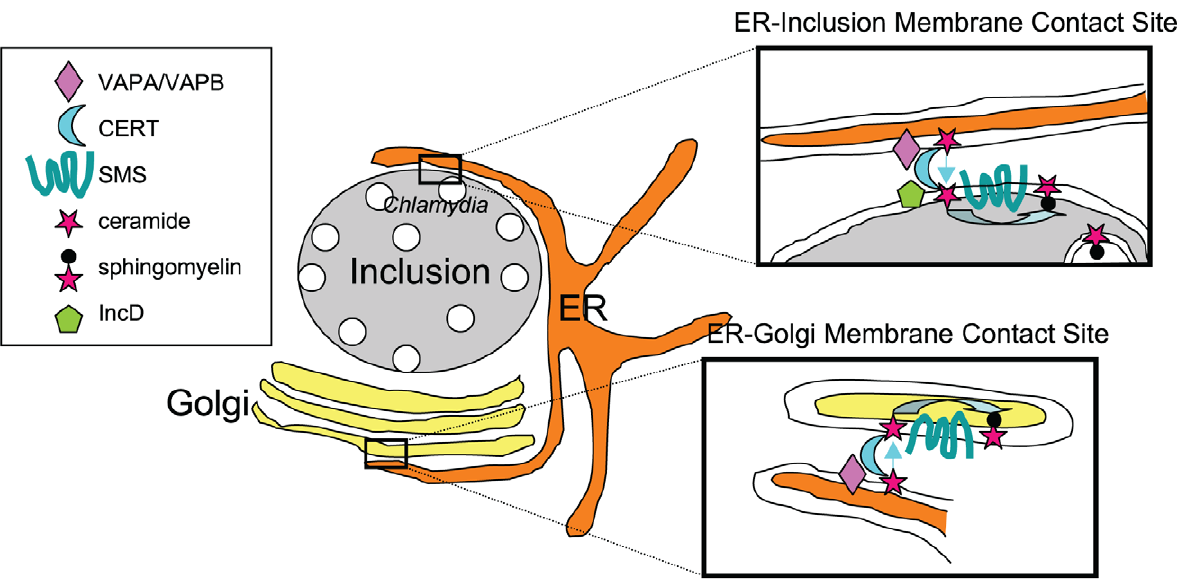
Figure 1. Direct transport of ceramide from the ER to C.trachomatis inclusion. At ER-Golgi membrane contact sites the ceramide transfer protein CERT associates to the ER-resident proteins VAPA/VAPB and, via its PH domain, to PI4P at the trans -Golgi. Upon transfer by CERT, ceramide is converted to SM by a SM synthase (SMS). In Chlamydia -infected cells, ER-inclusion membrane contact sites involving VAPA/VAPB and CERT are observed. CERT interacts with the inclusion-anchored bacterial protein IncD through its PH domain but independently of PI4P. Upon transfer to the inclusion membrane, ceramide might be converted to SM by host SMS, which is enriched around the inclusion, and incorporated by the bacteria. Because the catalytic site of SMS is in the lumenal site of the Golgi apparatus, it would imply that the enzyme traffics to the inclusion membrane to convert ceramide, by a mechanism that remains to be determined. Other possibilities for SM acquisition by the bacteria are discussed [8]. Alternative routes for the transfer of SM and other lipids to the Chlamydia are discussed in an excellent recent review